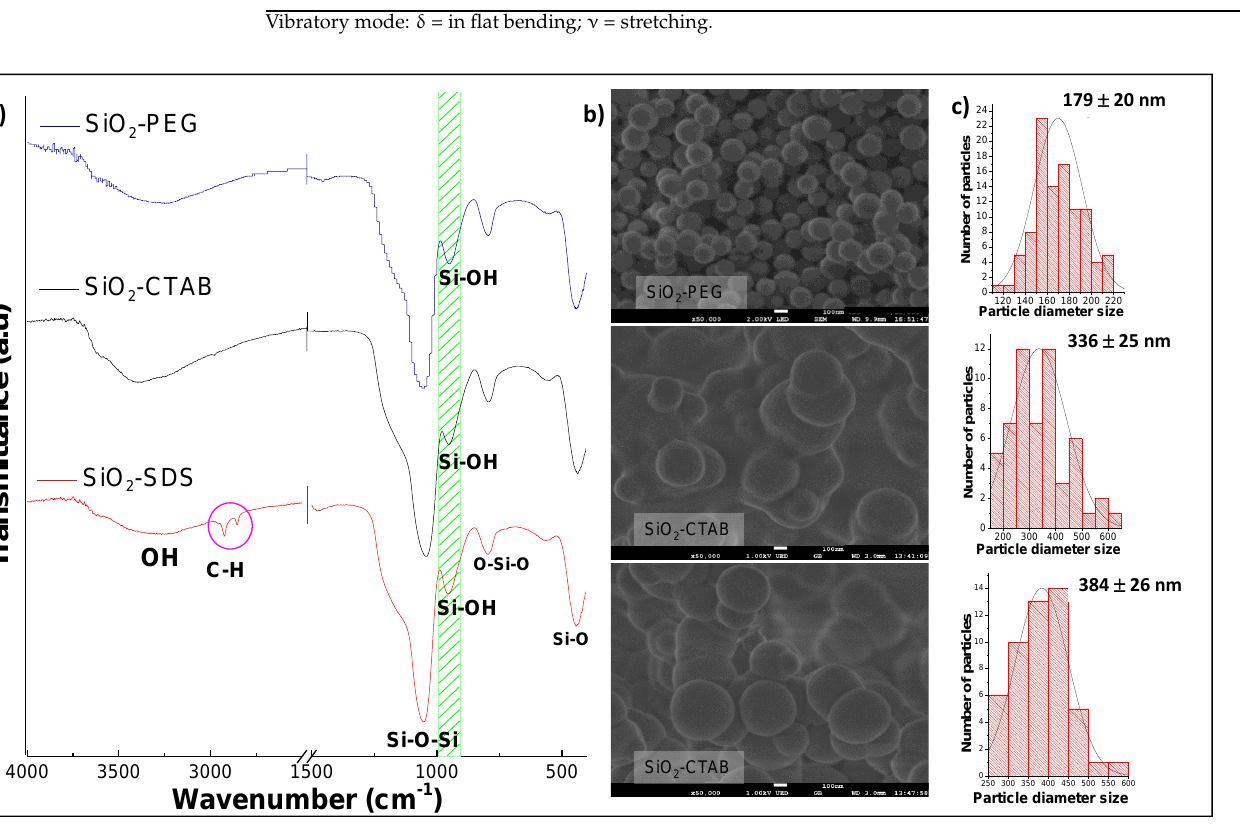
Figure 1. ( a ) Fourier transform infrared spectroscopy with attenuated total reflectance (FTIR-ATR) spectra and ( b ) micro- graphs at 50,000 X, and ( c ) particle size distribution of SiO 2 -PEG, SiO 2 -CTAB, andSiO 2 -SDS samples.